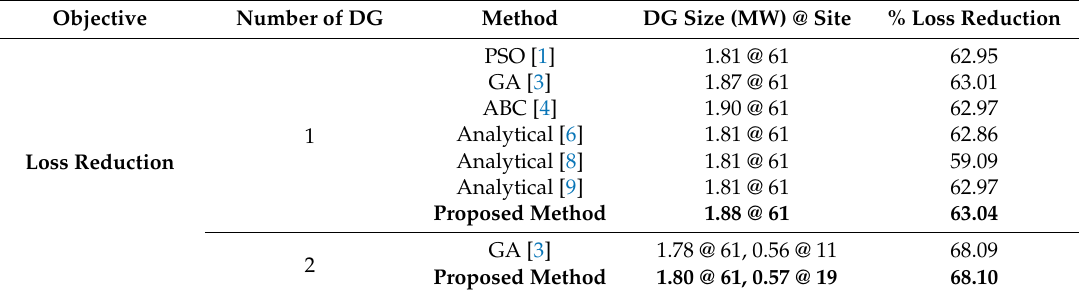
Table 9. Comparative